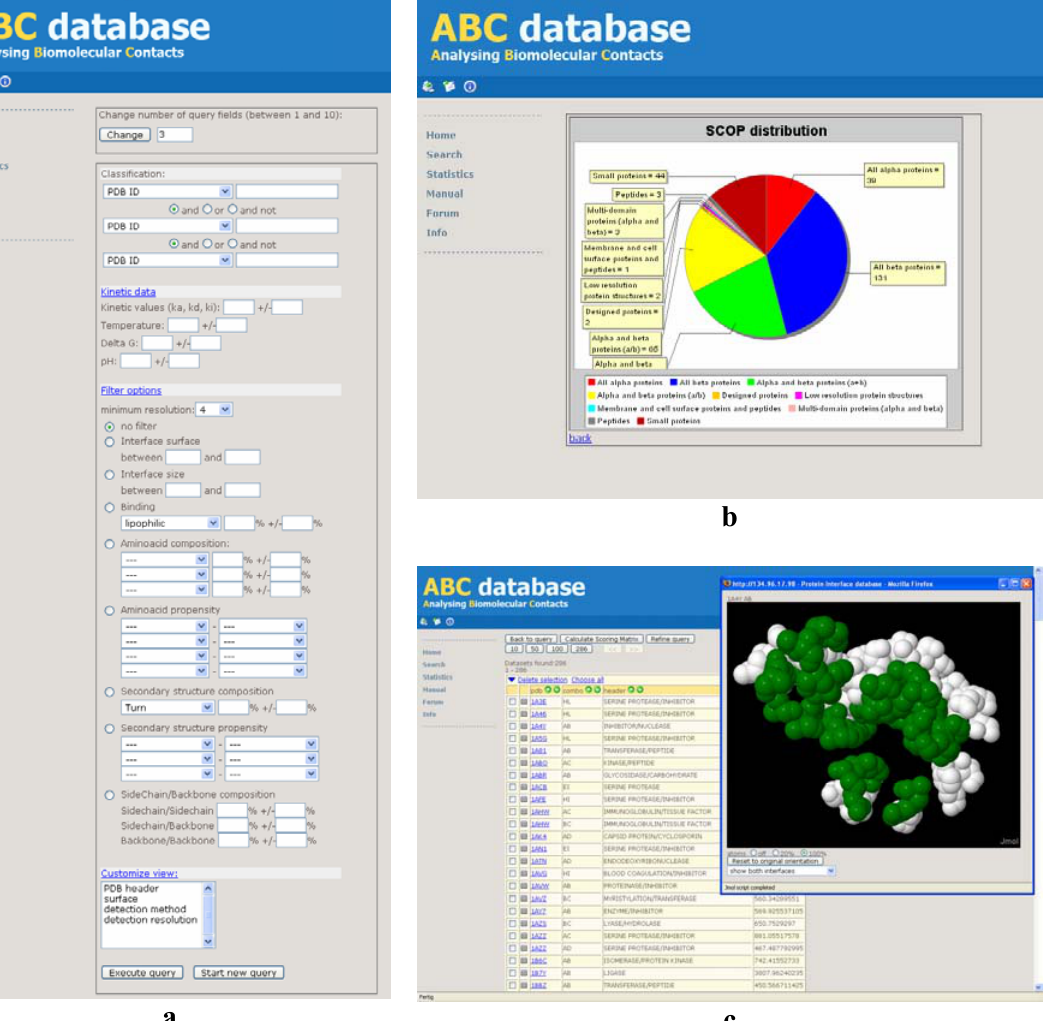
Figure 2: Database screenshots: (a) shows the query screen of the ABC database. The diagram in (b) was made by JfreeChart and represents the distribution of SCOP classifiers in our dataset. A result list is represented as table in (c). The three-dimensional structure of an interface or complex can be displayed with the integrated molecule viewer JMol.